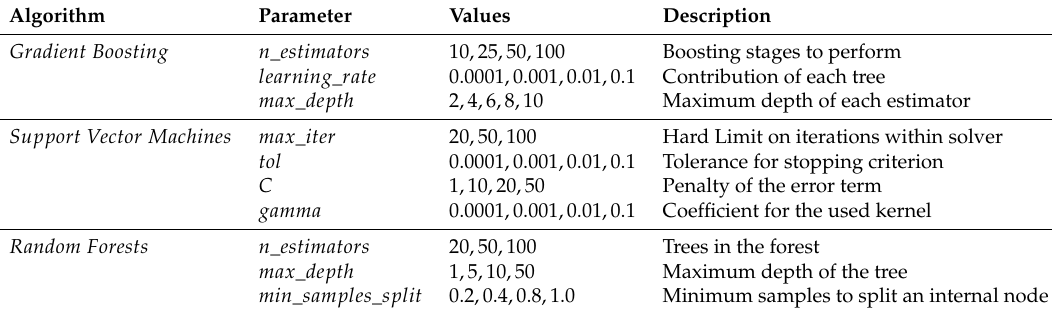
Table 2. Intra-parameters